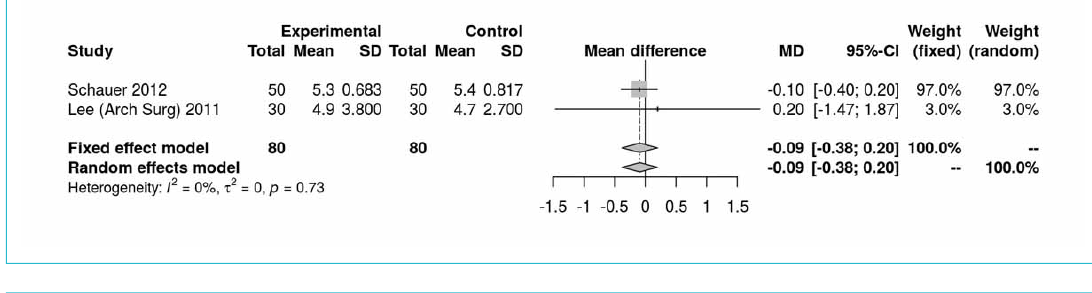
Figure S6f: Glycated haemoglobin (HbA1c) at baseline (analysis of studies including only patients with type 2 diabetes).